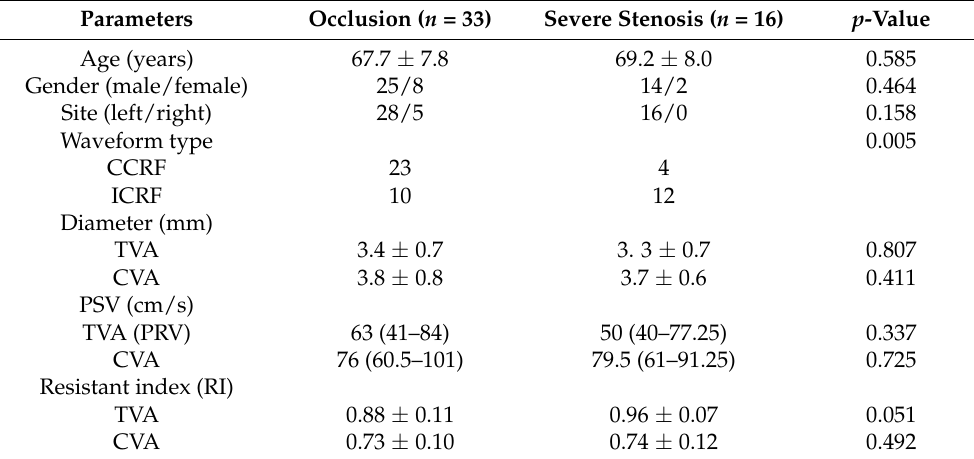
Table 3. Comparison of two subtypes of CRF and VA parameters between the SA occlusion group and the severe stenosis group.